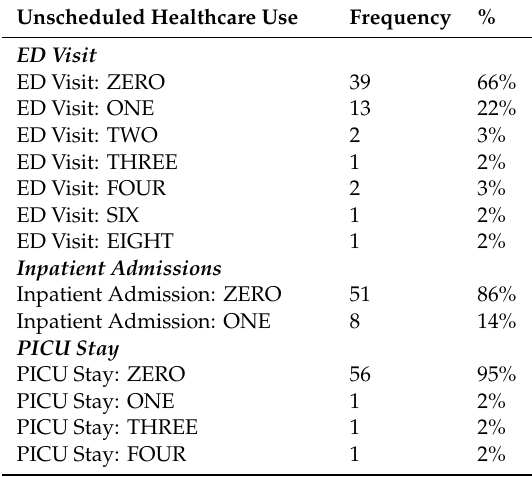
Table 4. Frequency distribution of unscheduled healthcare